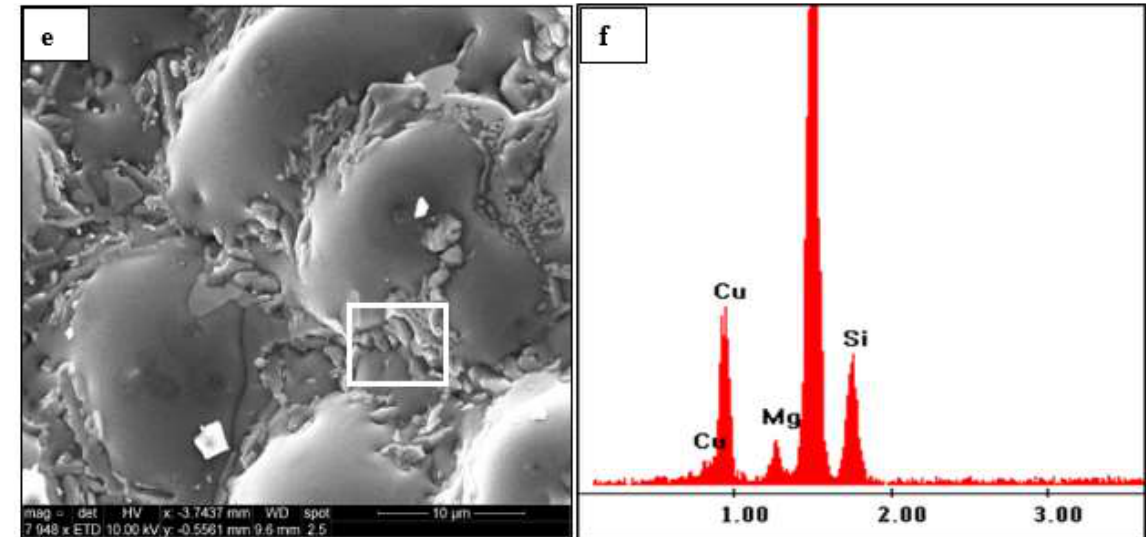
Figure 16. Secondary electron images showing the fracture surface of alloy B tested at 25 °C: ( a ) as- cast condition; ( b ) after T6 treatment; ( c ) after T7 treatment condition 13; ( d ) an enlarged micrograph of ( c ), ( e ) alloy D in the heat-treated condition 13; ( f ) EDS spectrum corresponding to ( e ). The blue arrow in ( b ) indicates the tensile direction.